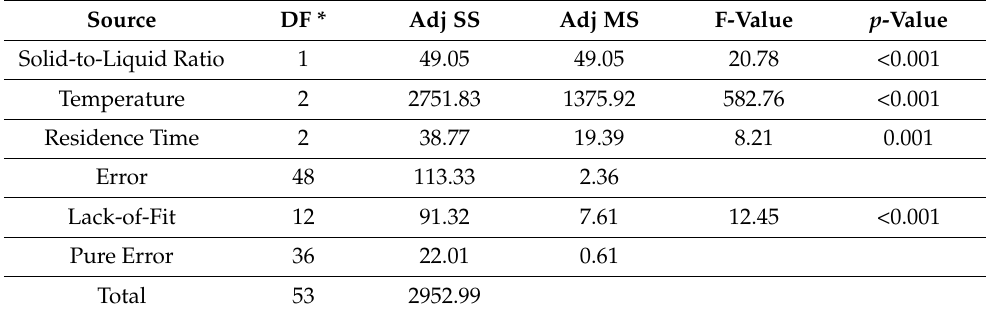
Table 3. The ANOVA variance analysis.